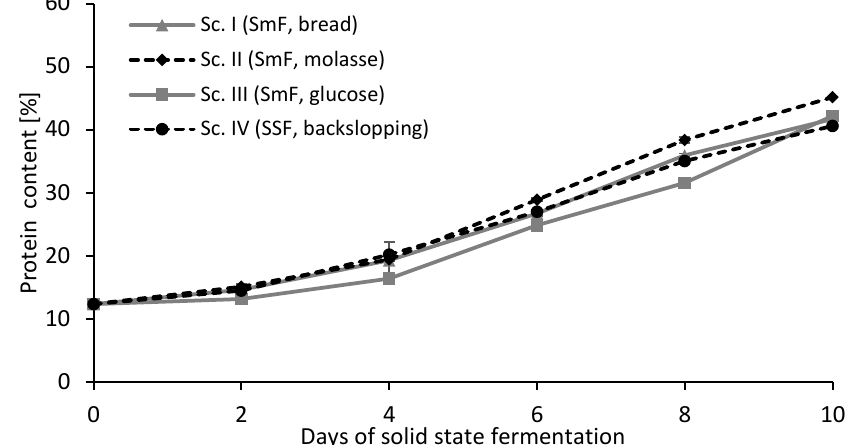
Figure 2. Solid-state cultivation on stale sourdough bread using N. intermedia after 0 – 10 days culti- vation under light at 35 °C, 90% Rh, and 40% initial moisture content using different inoculation methods: backslopping (black circle, dotted line), submerged fermentation with synthetic medium based on glucose (grey square, solid line), submerged fermentation based on molasses (black dia- monds, dotted line) and submerged fermentation based on breadcrumbs (grey triangles, solid line). Results are expressed as the mean value ± 95% confidence level.